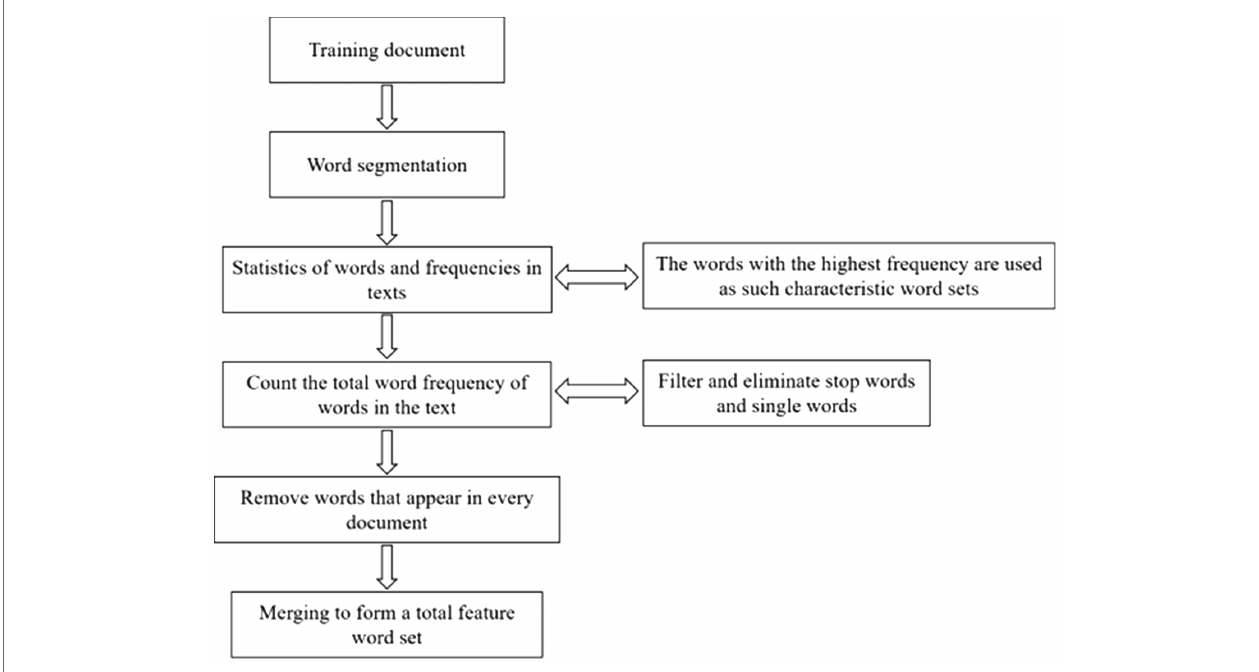
FIGURE 7 | Extraction steps of feature